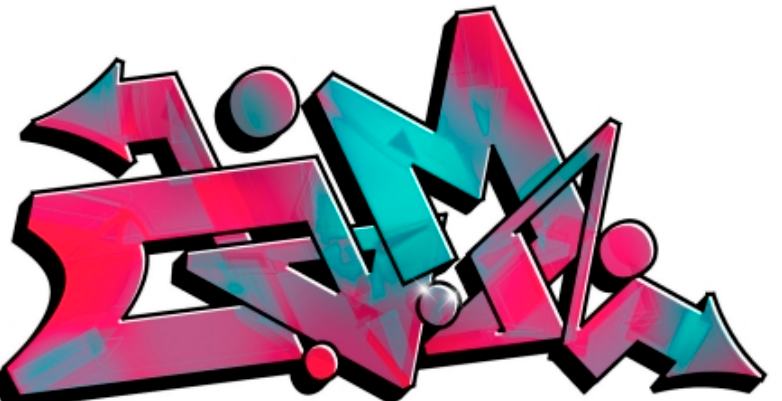
Figure 12. A.I.M.: Art.Intelligence.Machine., by Daniel Berio with the AutoGraff system (Berio 2021), a graffiti tag at the intersection of the arrow and machine styles in the words of Dado, an artist and theoretician of graffiti art (Ferri 2016).